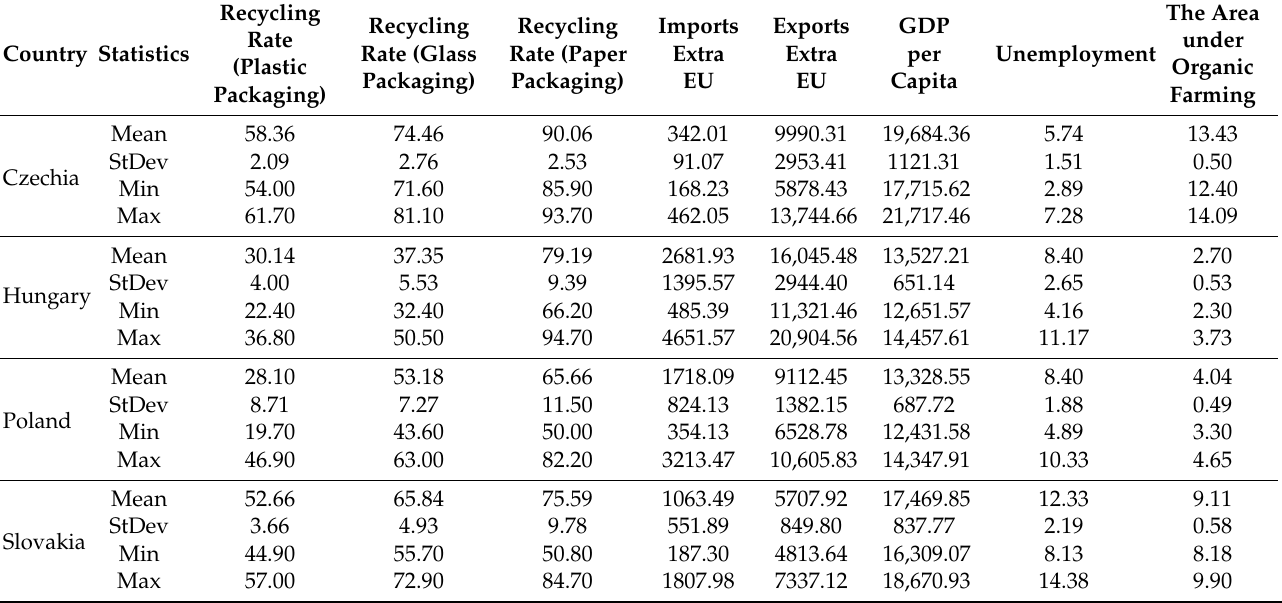
Table 2. Descriptive statistics of explanatory variables.